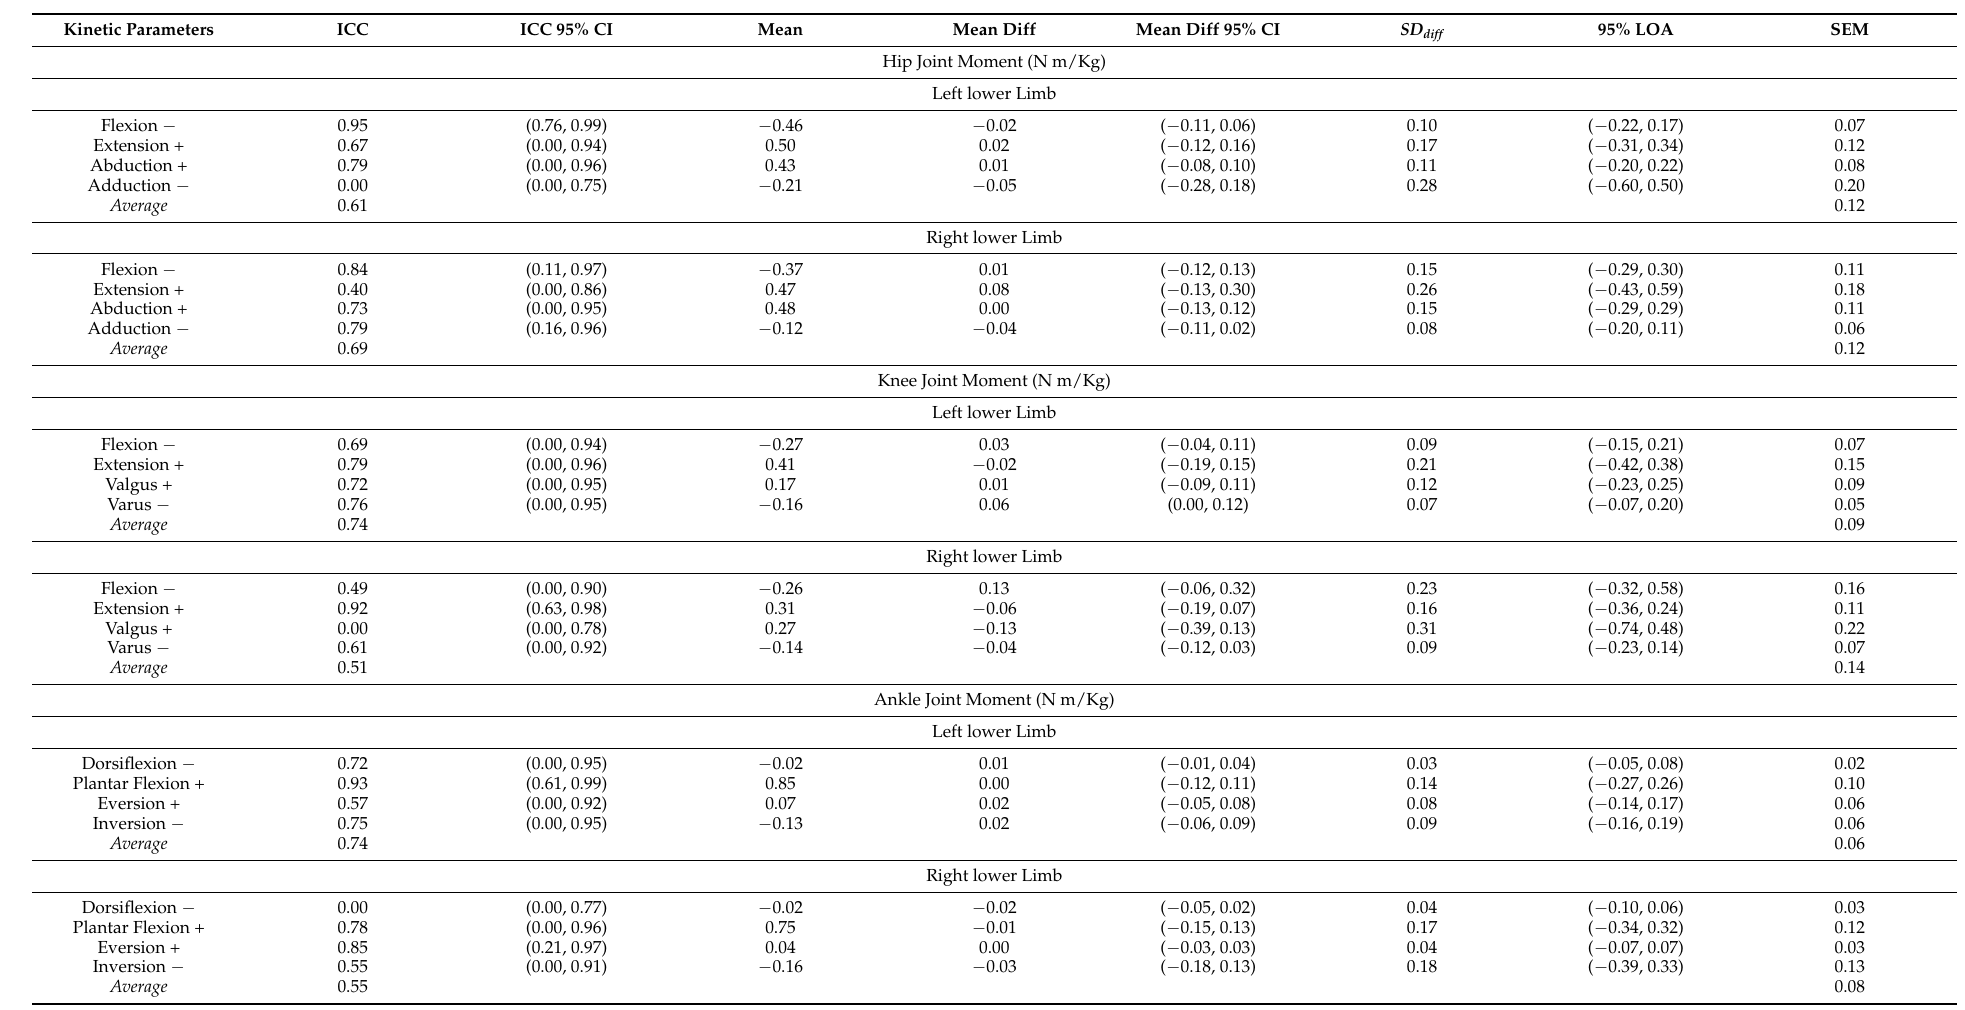
Table 5. Reliability values for kinetic